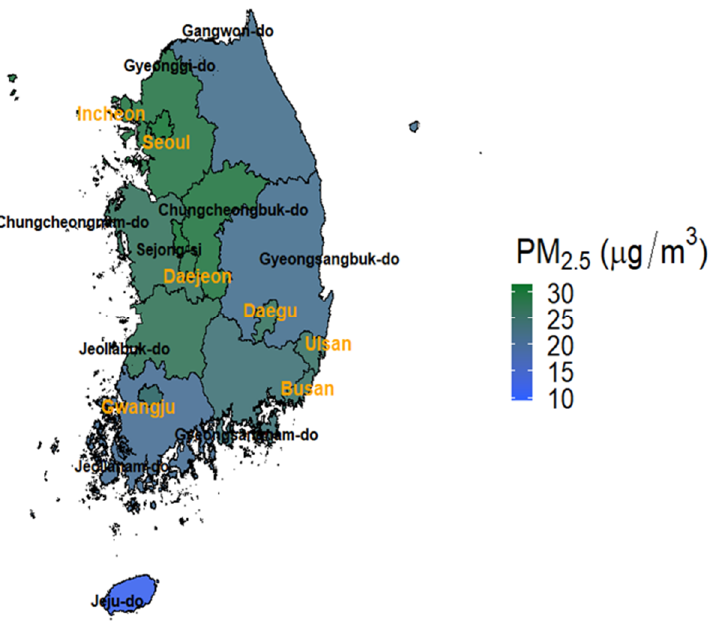
Figure 1. Map of Korea and average fine particulate matter (PM 2.5 ) concentrations during the study period (2008–2016). The names of seven metropolitan cities are indicated with orange color.